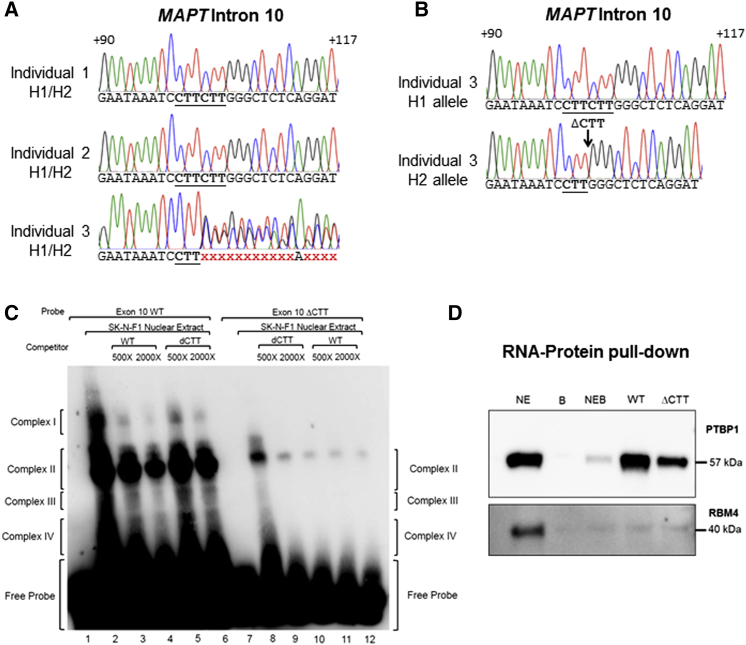
A Deletion in MAPT Intron 10 Decreases Binding of Factors that Regulate Exon 10 Splicing(A) Sequencing chromatograms for MAPT intron 10 showing the expected sequence for genomic DNA (both H1 and H2 alleles together) for individuals 1 and 2. The red x's represent divergent chromatograms from two overlapping sequences caused by an indel on one allele for individual 3.(B) Sequencing chromatograms for MAPT intron 10 showing single allelic genomic DNA from individual 3. The H2 allele showed a ΔCTT variation.(C) Electrophoretic mobility shift assay using an RNA probe for an intron 10 wild-type (WT) sequence (lanes 1–6) and an RNA probe for an intron 10 ΔCTT variant sequence (lanes 7–12), with and without competitors.(D) Western blot of RNA-protein pull-down using the WT and ΔCTT RNA probes. Lanes indicate proteins obtained from nuclear extract only (NE), beads only (B), NE and B (NEB), WT RNA probe and the ΔCTT probe. Blots are shown for PTPB1 and RMB4. See also Figure S5.